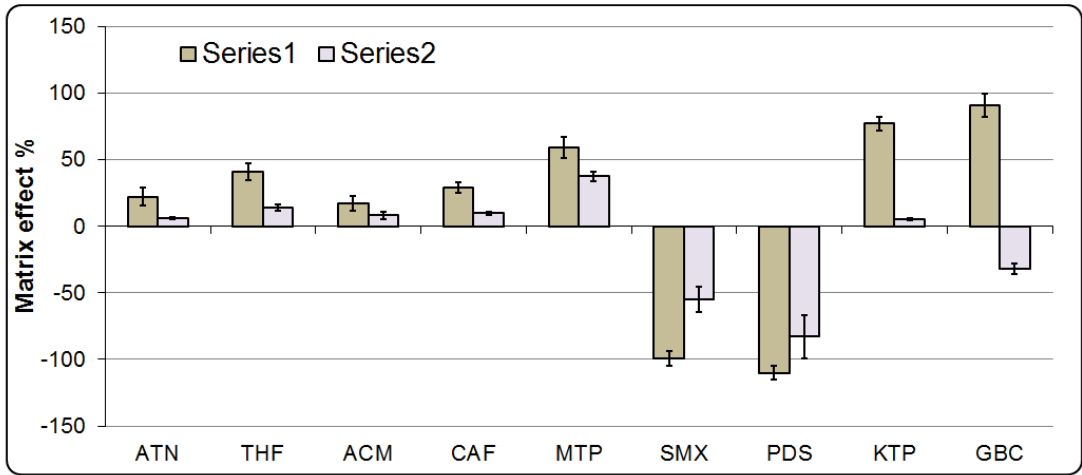
Figure 7. Percent matrix effect of pharmaceuticals (Spiking level 10 ng/mL, n = 5) from influent and effluent sewage treatment plant.